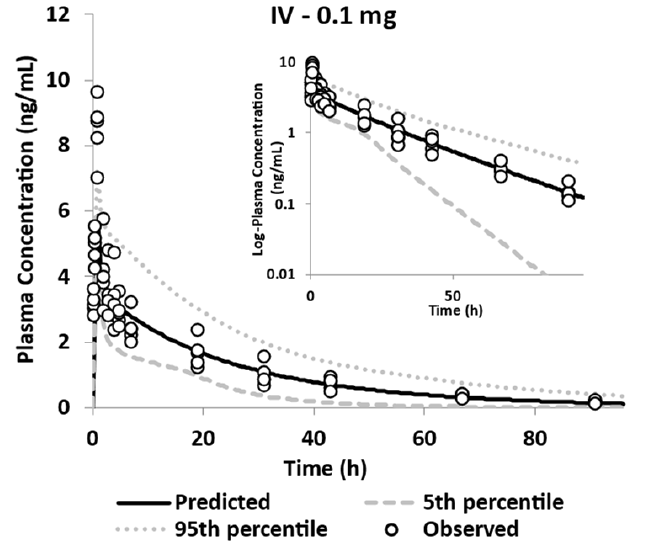
Figure 5. Observed and simulated plasma GSK254 concentration profiles of IV microdosing of GSK254 in healthy volunteers (n = 5, ADME study [12]). Table 5. Observed vs. predicted pk parameters of IV microdosing of GSK254 in healthy volunteers (ADME study